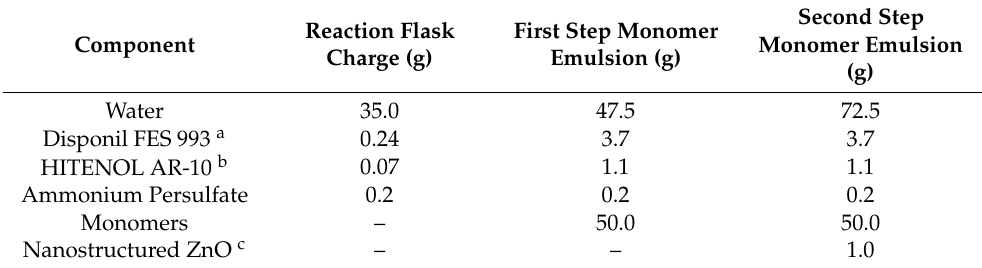
Table 3. Recipe for emulsion polymerization by using different surfactants and nanostructured ZnO